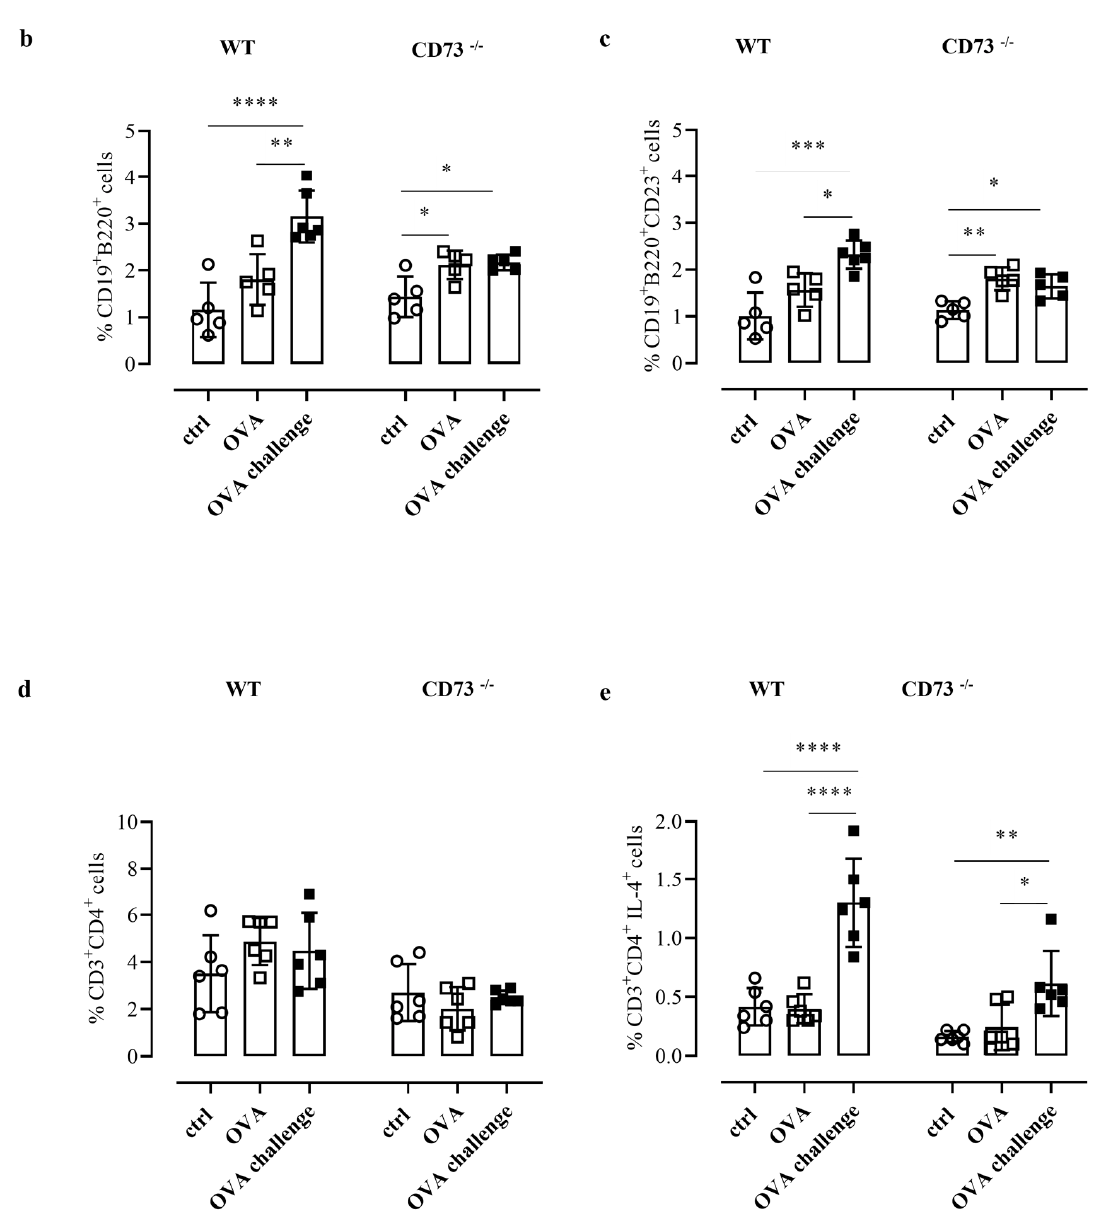
Figure 2. ( a ) Plasma levels of total IgE were measured in control and OVA-sensitized and challenged WT and CD73 − / − mice by ELISA. All results are expressed as mean ± SE of n = 4–6 mice per group. * p < 0.05 (one-way ANOVA followed by Bonferroni’s Multiple Comparison Test). The % of CD19 + B220 + was evaluated in control and sensitized and challenged WT and CD73 − / − mice ( b ) by flow cytometry as well as the % of CD19 + B220 + CD23 + ( c ). Data are expressed as means ± SE of five to six mice per group. * p < 0.05, ** p < 0.01,*** p < 0.001, **** p < 0.0001 (one-way ANOVA followed by Bonferroni’s Multiple Comparison Test). The % of CD3 + CD4 + and CD3 + CD4 + IL4 + in control and sensitized and challenged WT and CD73 − / − mice was analyzed by flow cytometry ( d , e ). Data are expressed as means ± SE of five to six mice per group. * p < 0.05, ** p < 0.01, **** p < 0.0001 (one-way ANOVA followed by Bonferroni’s Multiple Comparison